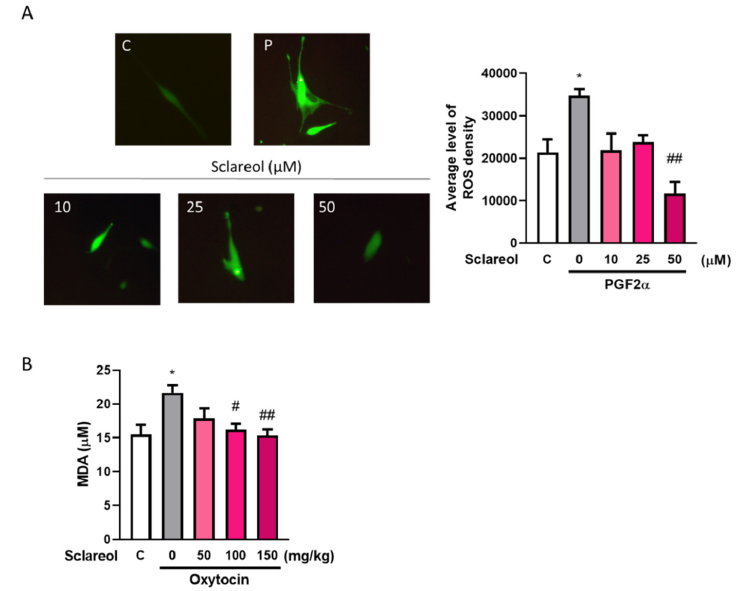
Figure 6. Effect of sclareol on oxidative stress in uterine smooth muscle cell and dysmenorrhea mice. ( A ) Reactive oxygen species (ROS) density in in vitro study. * p < 0.05 compared with control group, ## p < 0.01 compared with sclareol 0 µM group; C, control group. ( B ) Serum MDA concentration in oxytocin-induced writhing test. * p < 0.05 compared with control group; # p < 0.05, ## p < 0.01